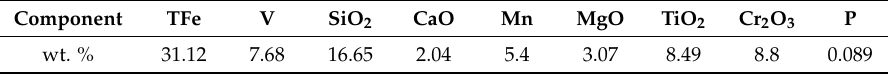
Table 1. Chemical compositions of vanadium slag before roasting (wt. %).